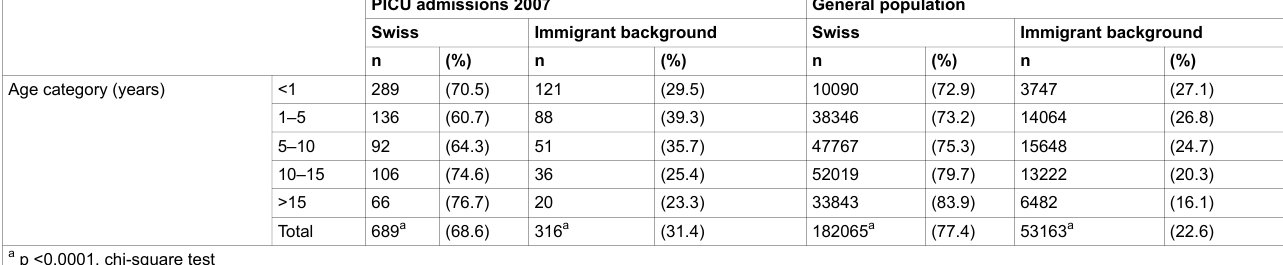
Table 3: Age distribution of immigrants in PICU and in the general population of the canton of Zurich.